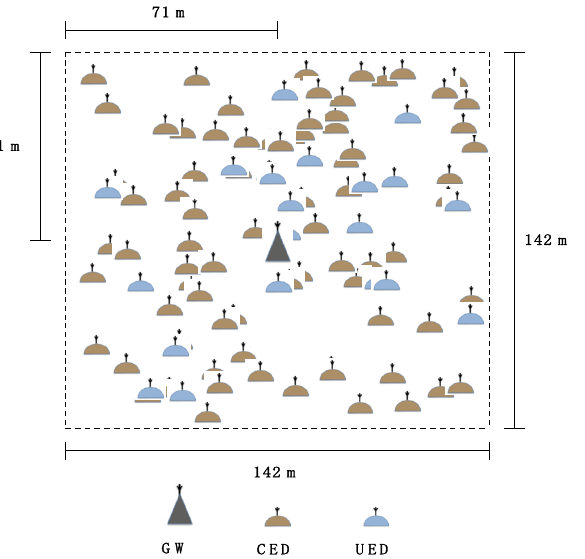
Figure 3. Example of EDs and gateway spatial distribution on the scenario area, where there are 80 CEDs.